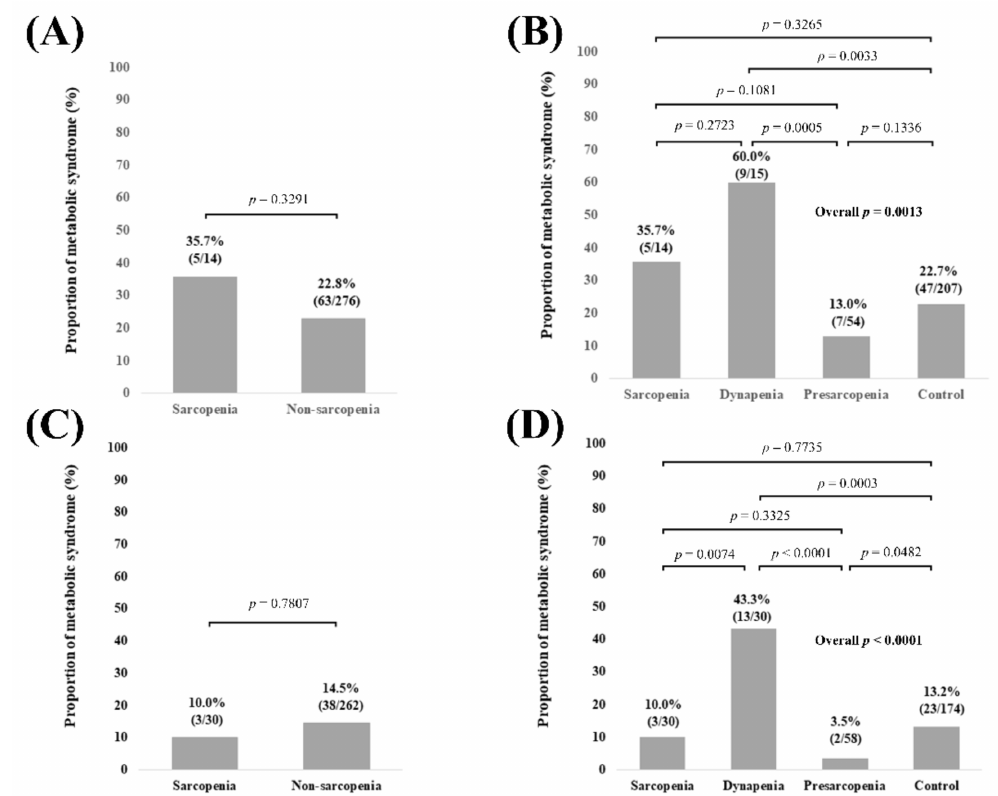
Figure 5. ( A ) Proportion of Met-S in patients with sarcopenia and non-sarcopenia in male patients (n = 290). ( B ) Proportion of Met-S in patients with sarcopenia, dynapenia, presarcopenia, and control in male patients. ( C ) Proportion of Met-S in patients with sarcopenia and non-sarcopenia in female patients (n = 292). ( D ) Proportion of Met-S in patients with sarcopenia, dynapenia, presarcopenia, and control in female